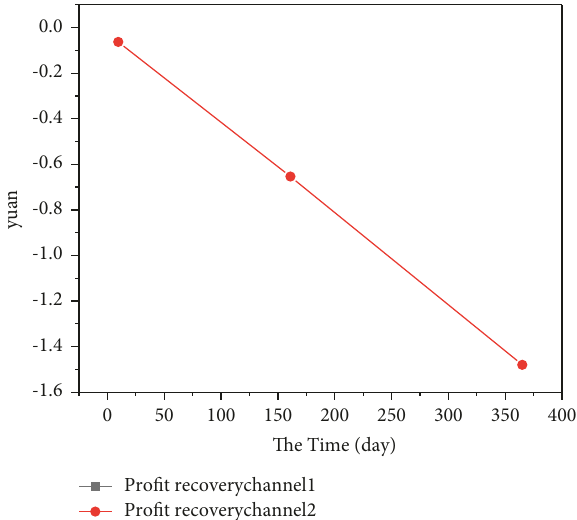
Figure 4: Double-channel packaging recycling profit comparison.